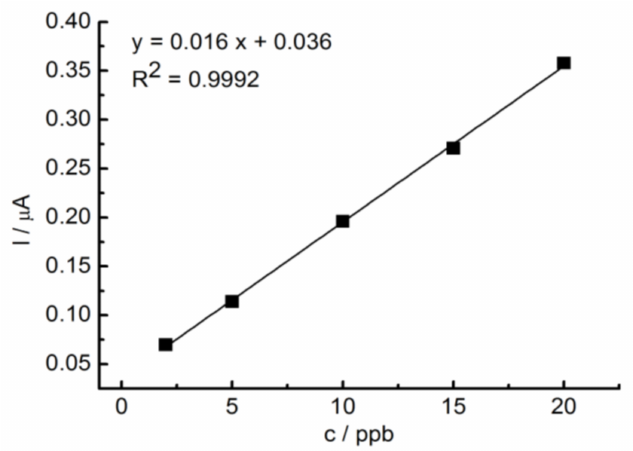
Figure 4. Calibration curve obtained for the GC/RGO electrode in EDTA after the addition of 2, 5, 10, 15, and 20 µ g L − 1 Tl + . Six hundred seconds of pre-concentration at − 1.2 V vs. Ag/AgCl, a pulse amplitude of 50 mV, and a step potential of 2 mV.